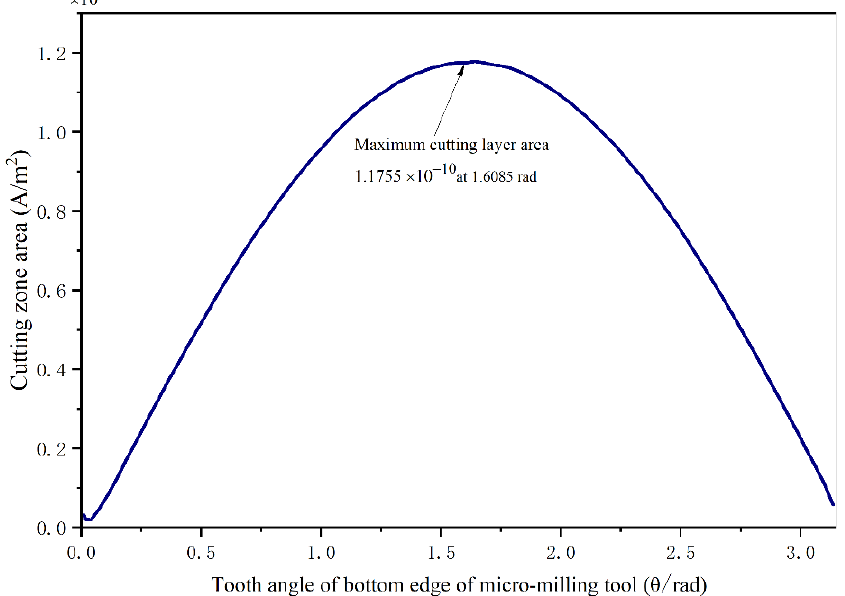
Figure 18. Simulation of cutting layer area.